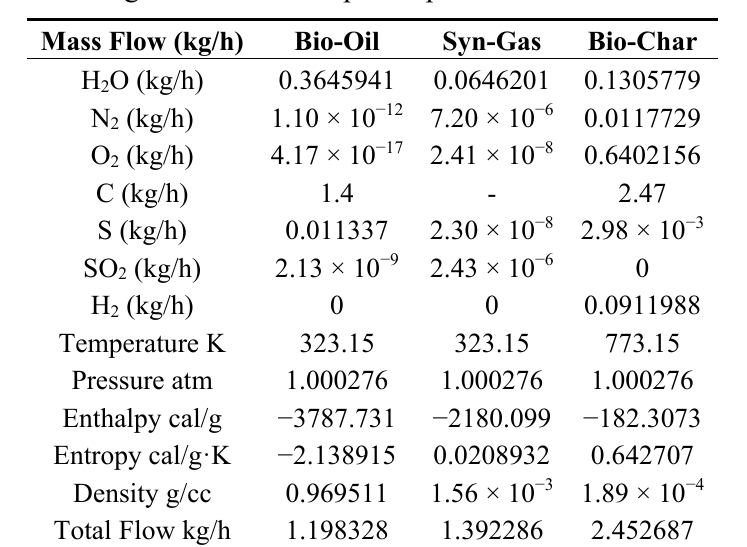
Table 5. Some MGW pyrolysis yield products data from Aspen Plus simulation at 500 °C, process heat airflow 12 kg/h and one atmospheric pressure.